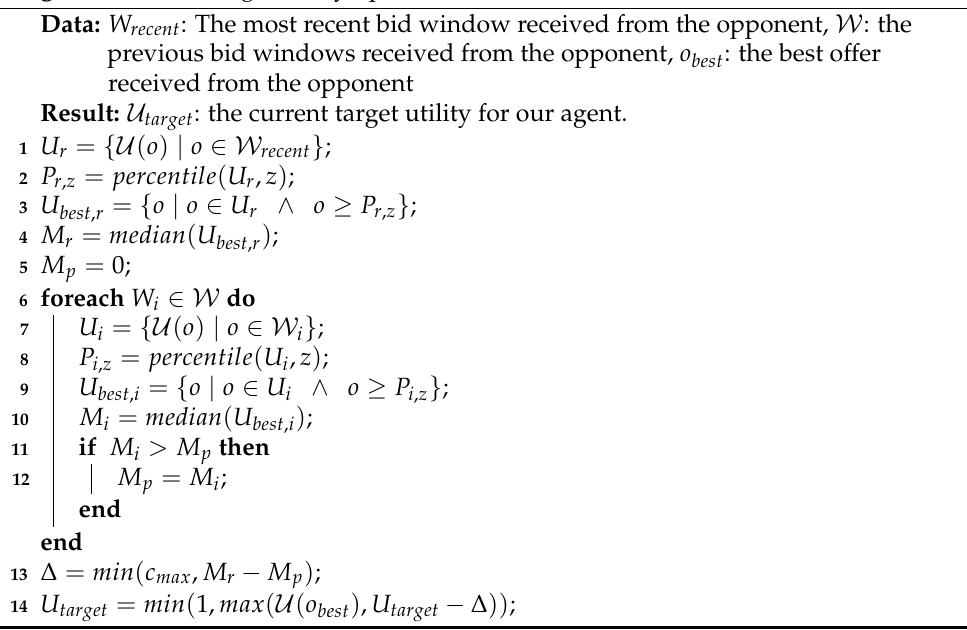
Algorithm 1: The target utility update